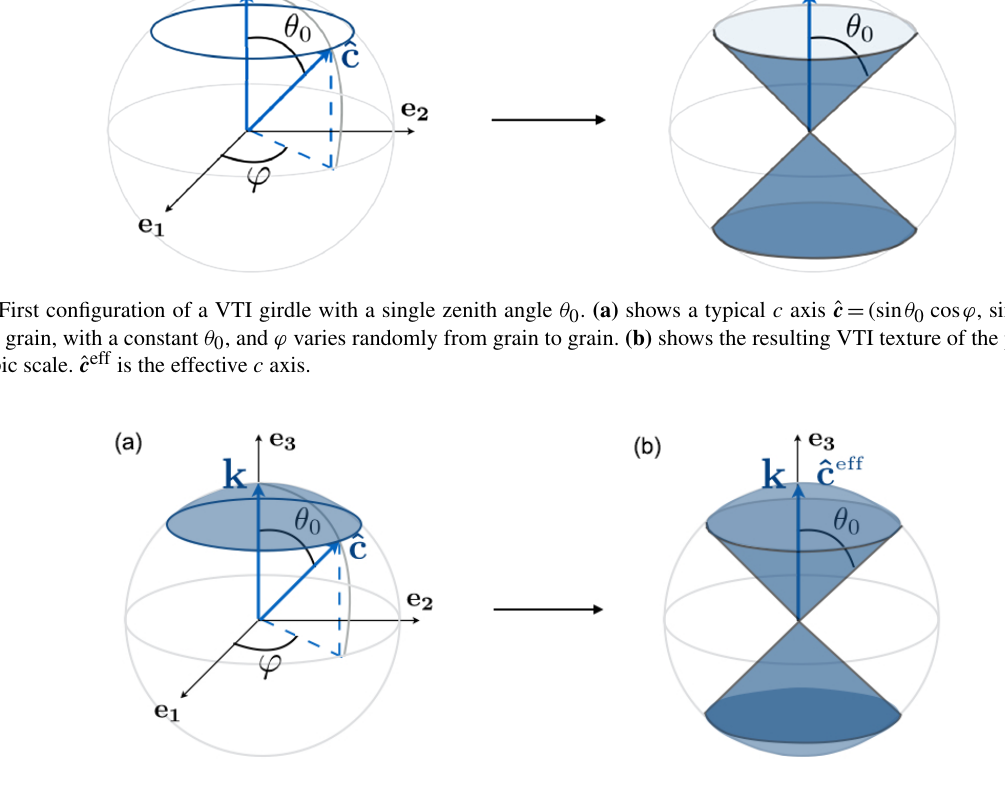
Figure 3. Second configuration of the usual VTI clustered texture. (a) shows a typical c axis ˆ c = (sin θ cos ϕ , sin θ sin ϕ , cos θ ) within one grain, where θ varies in [0, θ 0 ] and ϕ varies randomly from grain to grain. (b) shows the resulting clustered, VTI, texture of the polycrystal at the macroscopic scale. ˆ c eff is the effective c